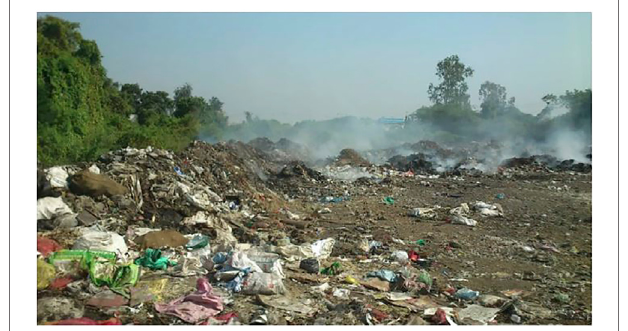
FIGURE 2 | The Effect of Soil Pollution on the living (Baruah, 2020).